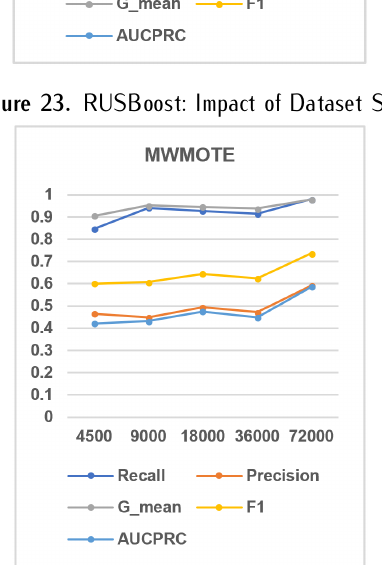
Figure 24. MWMOTE: Impact of Dataset